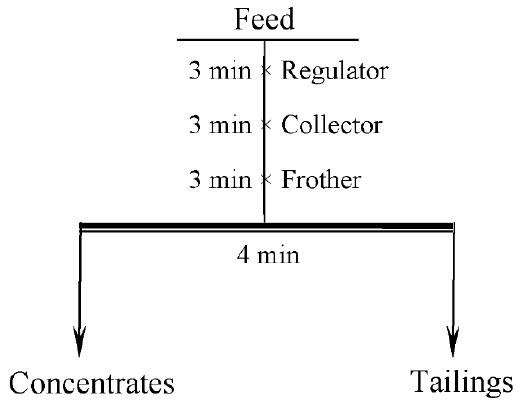
Figure 3. Flotation experiment process.